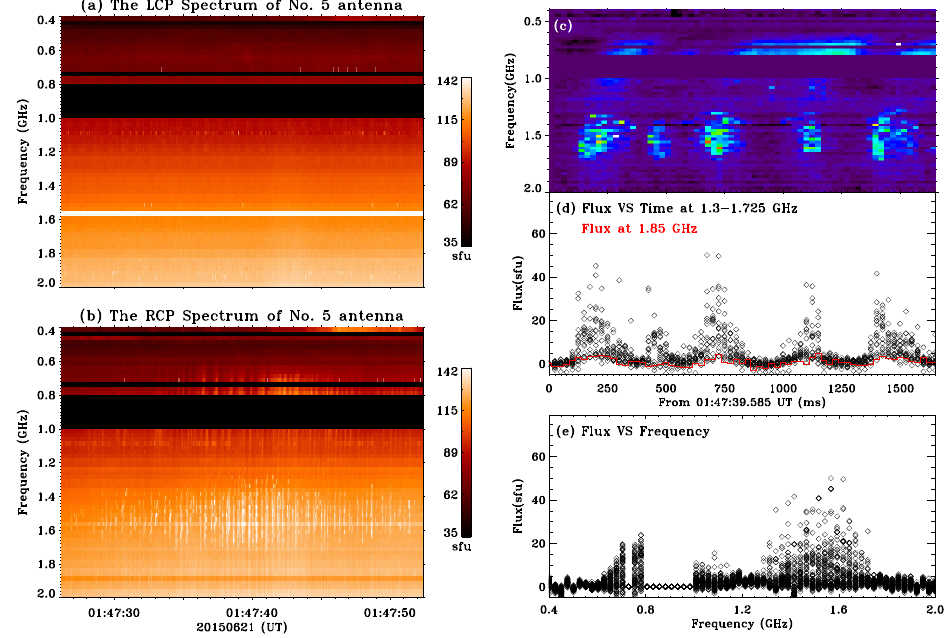
Figure 4. ( a , b ) The spectrum from 01:47:26.135 UT to 01:47:51.135 UT in LCP and RCP observed by the No.5 antenna of MUSER-I. ( c ) The zoomed-in spectral structure of QPSs from 01:47:39.585 UT. ( d ) The temporal evolution of the intensity of spikes by subtracting the continuum emission. ( e ) The frequency distribution of the intensity of spikes by subtracting the continuum